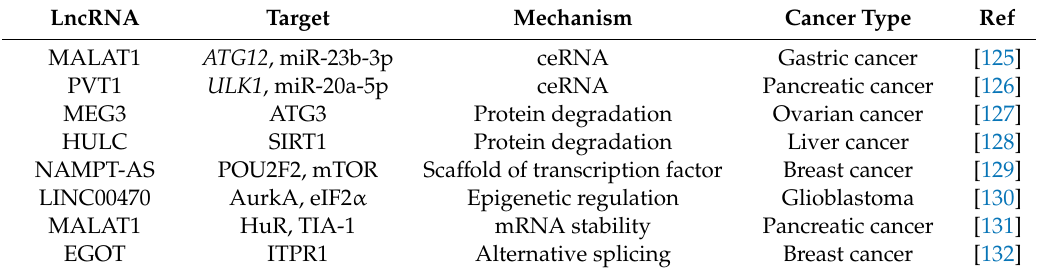
Table 5. LncRNAs regulate ‘autophagy in cancer’ through diverse